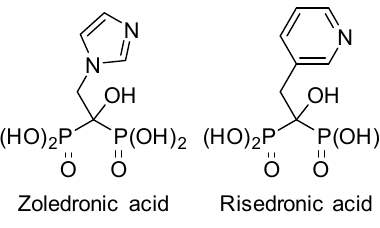
Figure 1. Bisphosphonate drugs.